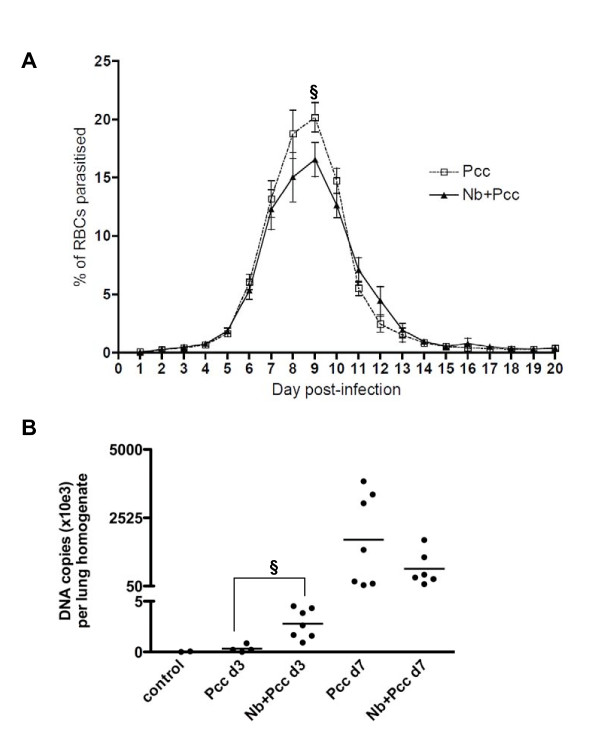
Malaria parasites in the blood (A) and lungs (B) of Pcc-infected and co-infected mice. (A) Co-infected mice (Nb+Pcc) had a lower peak proportion of parasitized RBCs than Pcc-infected mice did (P = 0.0465), as determined by 1000× microscopic examination of Giemsa-stained thin blood films. Means ± SEM from combined results of 3 independent experiments (each with 4-9 mice per group per time point) are shown. (B) Co-infected mice harboured greater numbers of Pcc genome copies per lung sample than Pcc mice at 3 days pi (P = 0.01), as assessed by real-time PCR of lung homogenates (derived from 75 mg lung) using MSP-1 specific primers. Genome copies were apparent in both Pcc infected groups at 7 days pi and the copy numbers no longer differed significantly between groups. This experiment included 4-7 mice per group. The symbol § indicates significance of the difference between co-infected and Pcc mice.